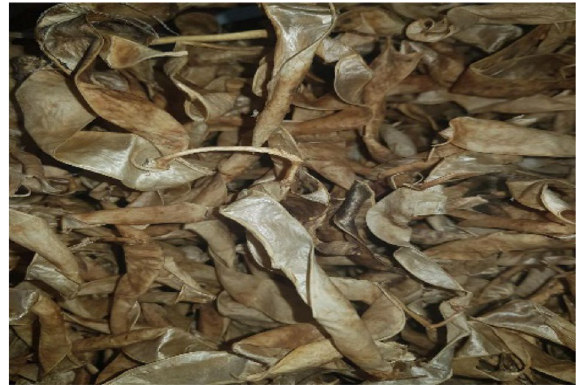
Figure 1. Bean bark (Bb).